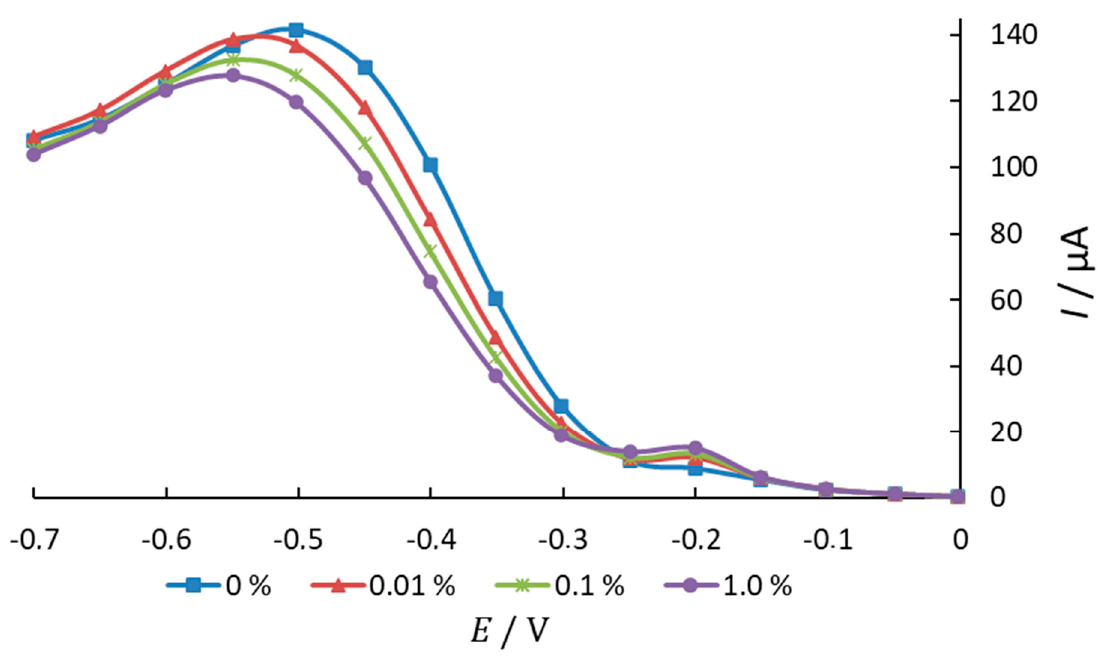
Figure 6. O 2 electroreduction current voltammogram (mercury–film electrode), background curve (0.1N NaClO 4 , 85% ethanol solution), and in the presence of various concentrations of phenothiazine (0.01%, 0.1%, and 1%).